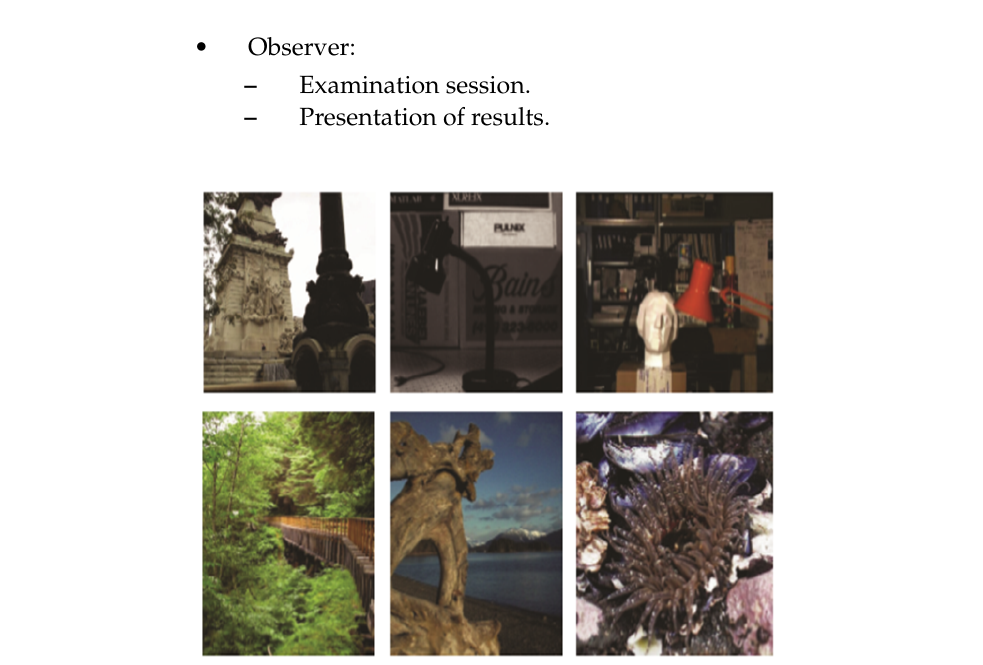
Figure 2. IRCCyN/IVC Image